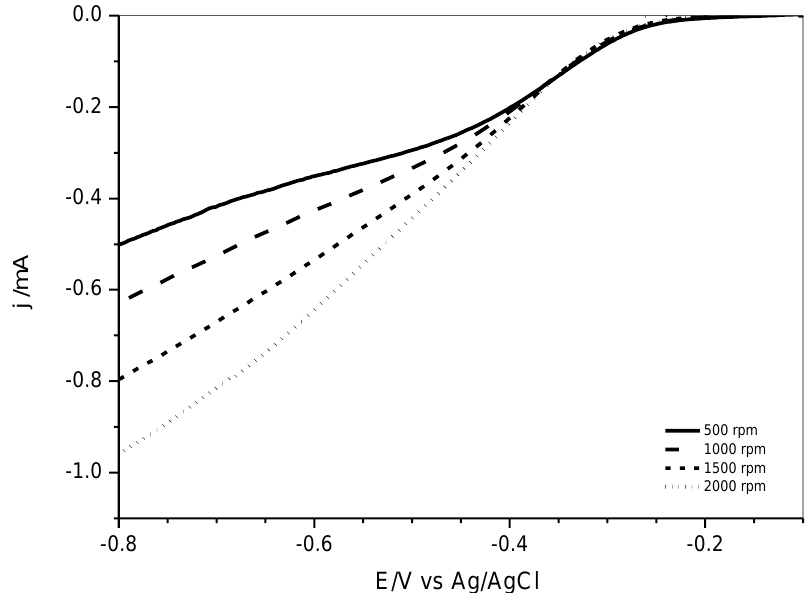
Figure 9. Linear scan voltammograms in O 2 -saturated 1 M KOH solution with various rotating speeds for PSU-TMA + PANI + GAH-Oct.